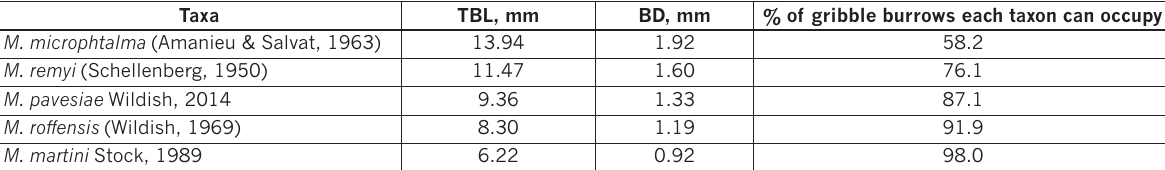
Table 4. Maximum total body length, mm (TBL) of adult female Macarorchestia from Pavesi et al. (2014), equivalent body depth, mm (BD) predicted from equation shown in the text and estimated percentage of available gribble burrows each taxon can occupy, based on data from the Bay of Fundy (Wildish and Robinson